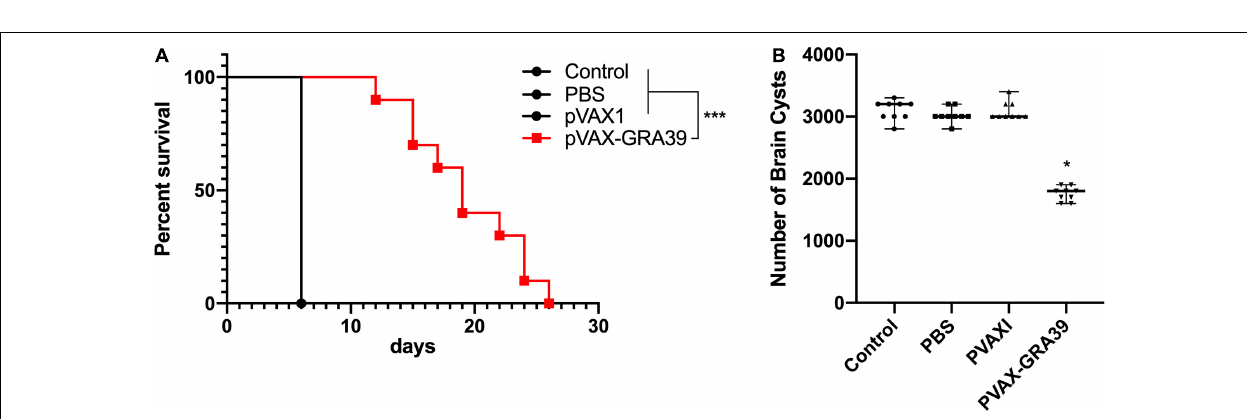
Frontiers in Microbiology |